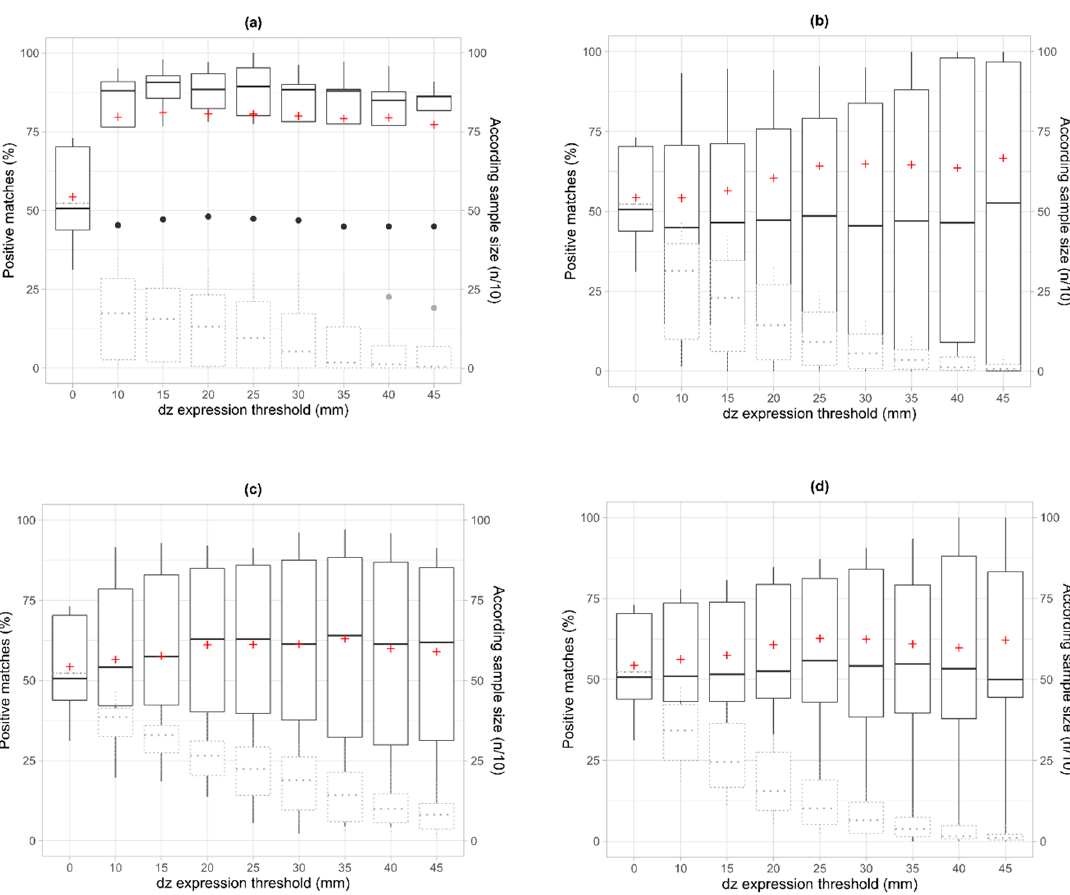
Figure 5. Development of positive matches (solid line boxes, cross marks the mean of all observations) and remaining sample segments (dash-lined boxes) between the ultrasound sensor data and the TLS data, when setting filters on a dz value for ( a ) only positive dz values of the TLS data, ( b ) only positive dz values on the ultrasound data, ( c ) absolute values of the TLS data, and ( d ) absolute values of the ultrasound data.